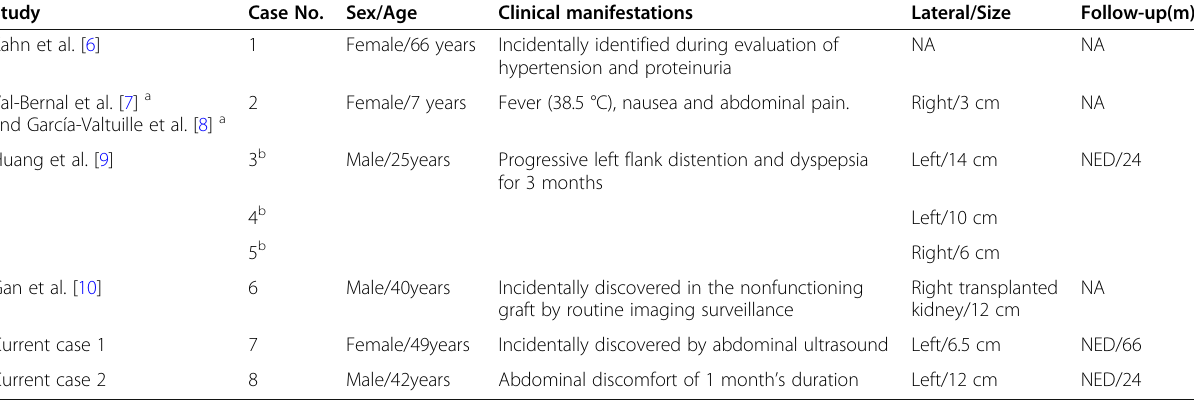
Incidentally discovered by abdominal ultrasound Left/6.5